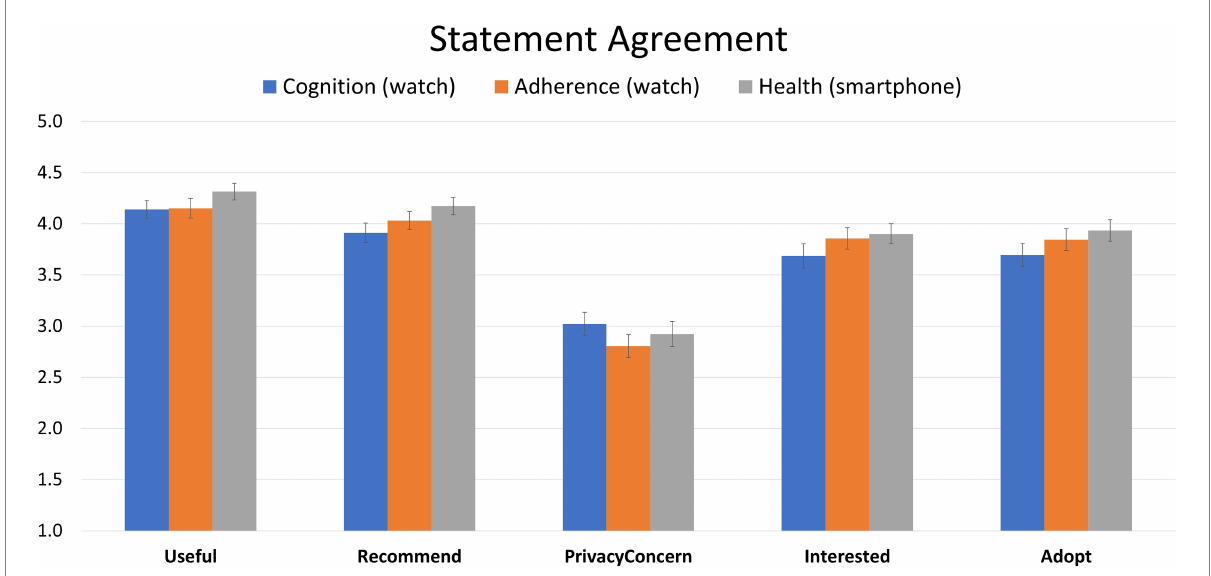
FIGURE 1 Average participant responses related to three different hypothetical technologies to support cognition, adherence, and overall health. Error bars represent +/- 1